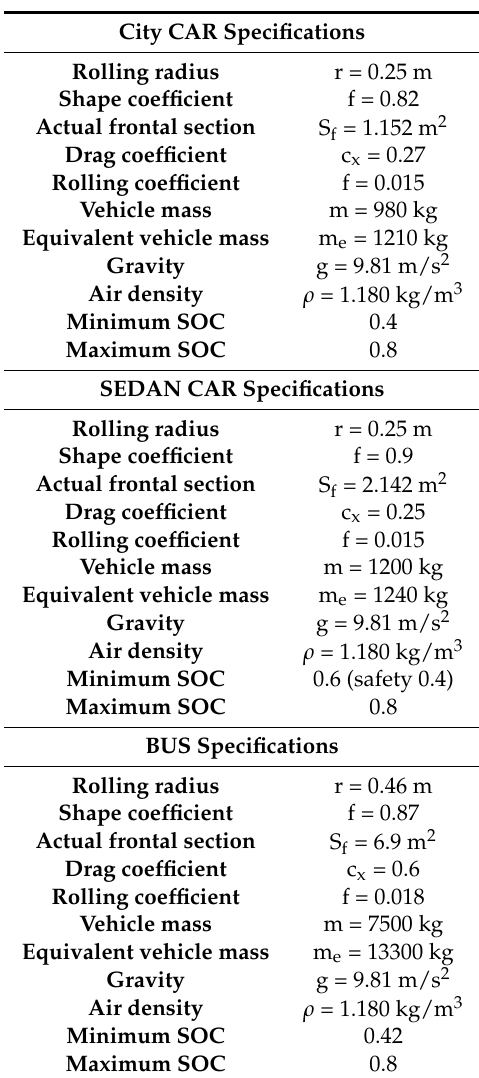
Table 13. Suggested Vehicles Specifications